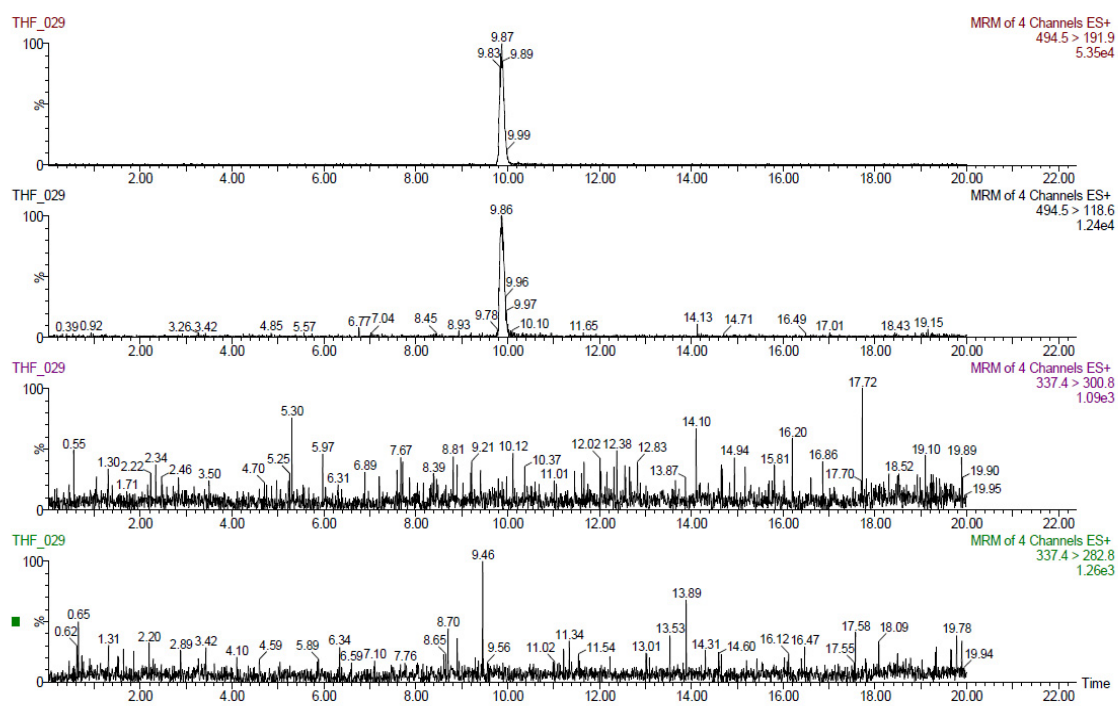
Figure A2. Chromatogram of a liver sample fortified with tiamulin at a level of 25 μ g/kg.